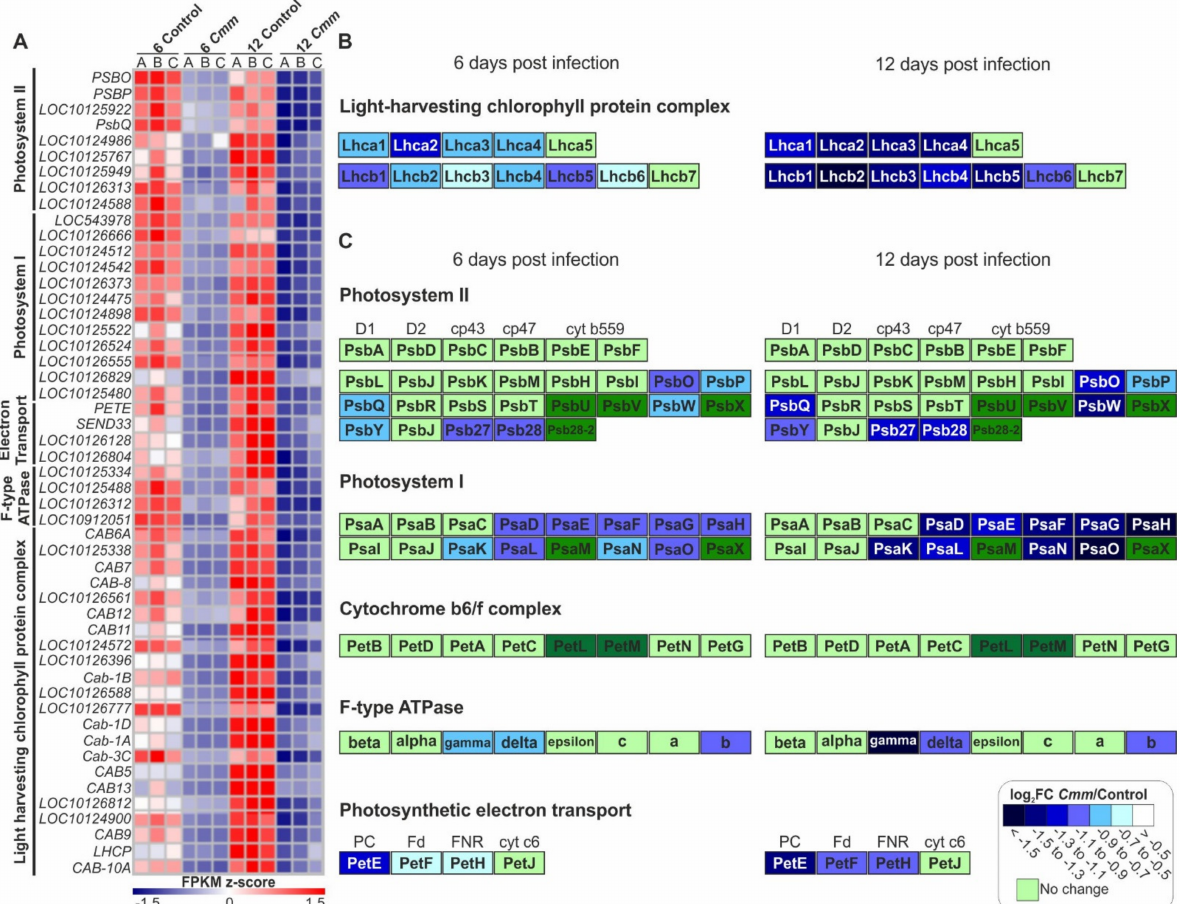
Figure 7. Tomato genes encoding protein components of the photosynthesis complexes were downregulated by Cmm . ( A ) Heat map visualizing the downregulation of genes involved in photosynthesis of Cluster V. ( B , C ) Comparative pre- sentation of Cmm infection on the expression fold change ( Cmm /control) of genes encoding components of tomato light harvesting complexes ( B ) and photosynthetic apparatus ( C ). In ( C ), the cells in dark green color represent components of tomato photosynthesis that has not been annotated